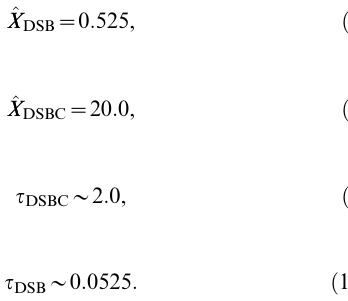
Figure 2. When there are a large number of repair proteins ~ 1000 ), the numbers of DSBs and DSBCs are fluctuating ( X max RP with a mean m , 20 and standard deviation s , 4.5.